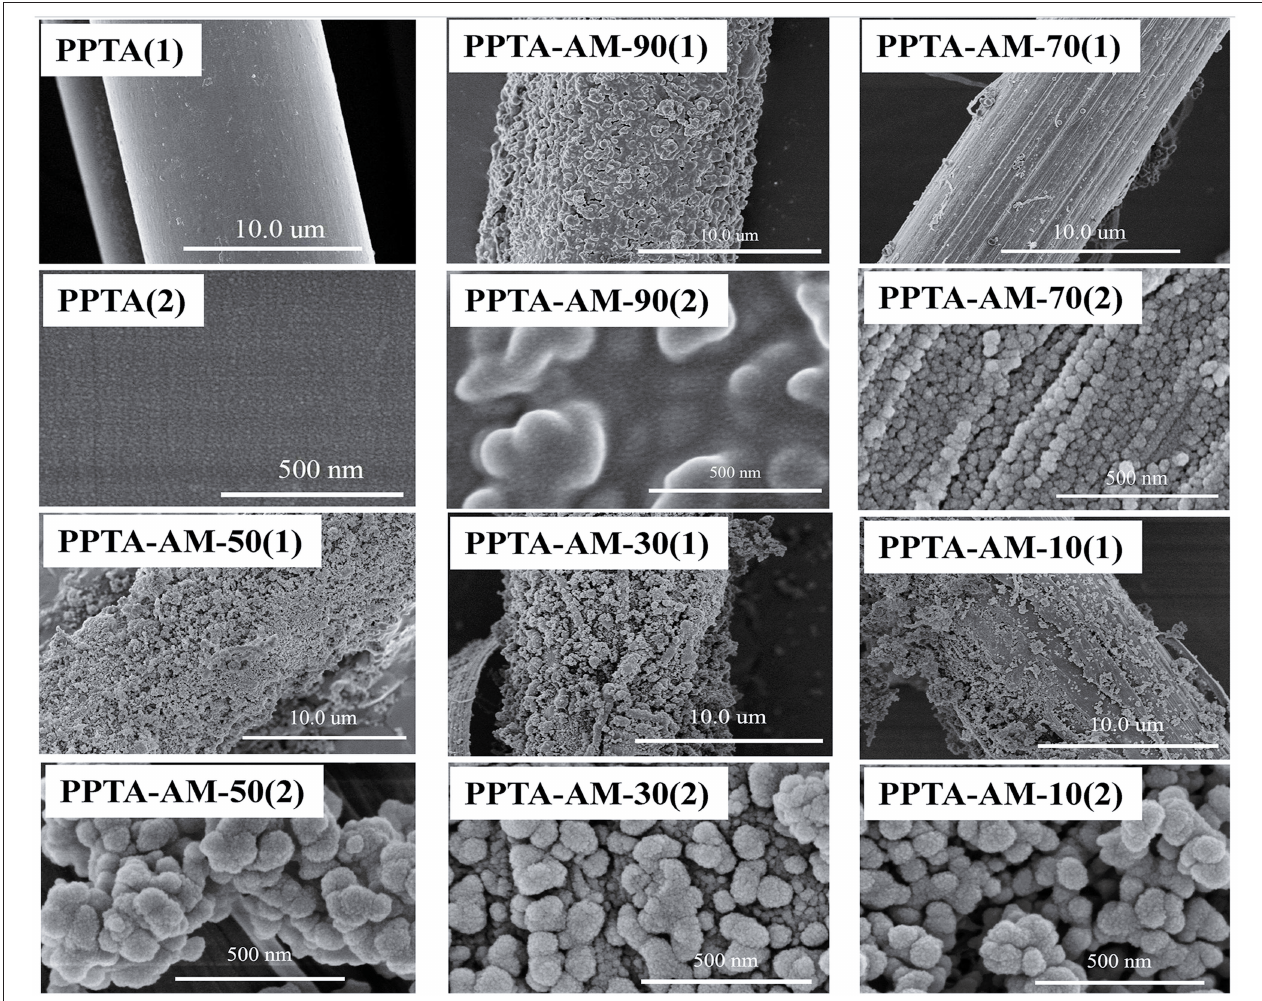
FIGURE 2 | FE-SEM images of PPTA and PPTA-AM samples.